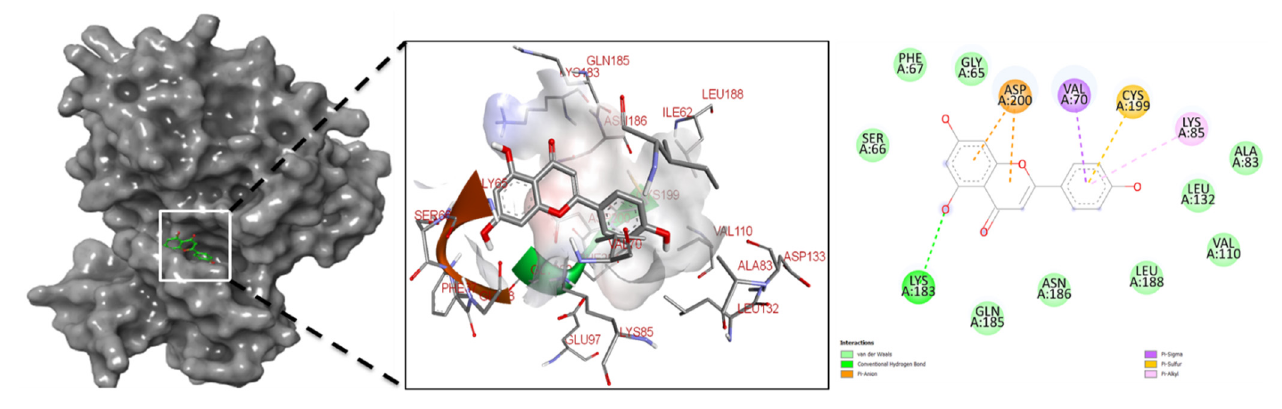
Figure 4. Molecular interaction studies of phytochemical constituents of H. sucuuba latex (Acacetin-7-O-neohesperidoside, luteolin,